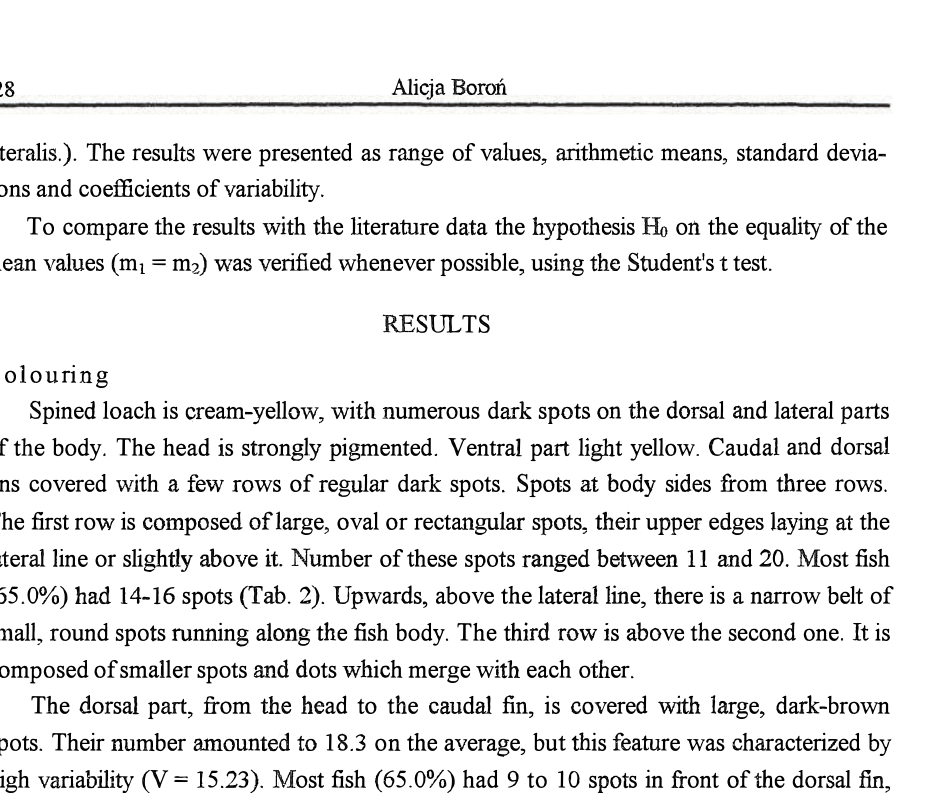
Scale cover, sex dimorphism Spined loach body is covered with small scales, overlapping each other, with no cen­ tral area (Fig. 1). One-year old males can be well distinguished from females as they possess Canestrini's or­ gan (Lodi 1980). It is a bony structure in form of an oval blade, growing at the base of the second ray of the pectoral fin. Male pectoral :fin is shaped differently than the female one because its second ray is longer than other rays. In females the longest ray is the third one, so Fig. L Scale pfspined loach. Magn. 60x their pectoral fins have different